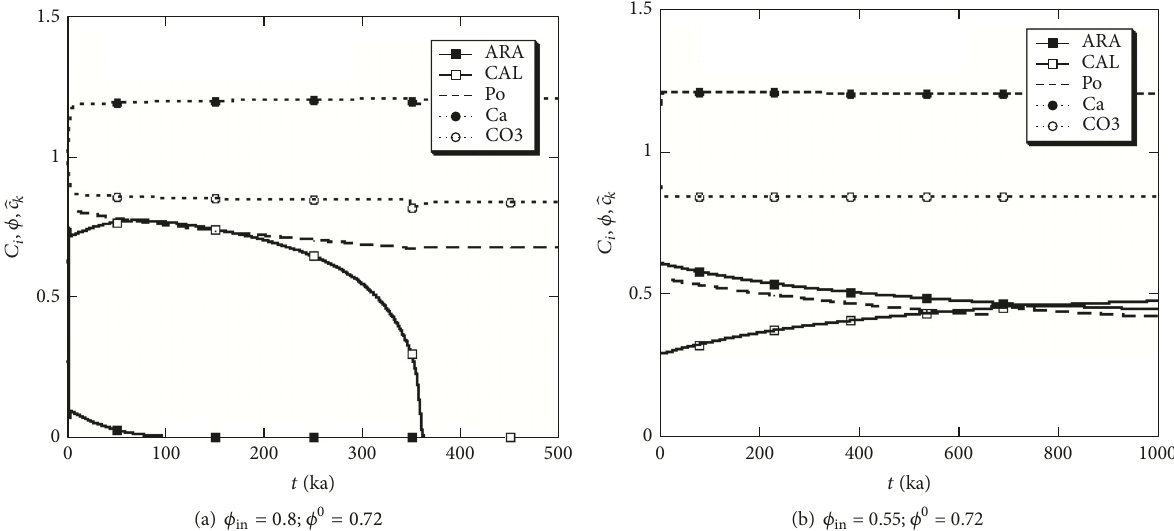
Figure 5: Numerical solutions for scenario A illustrating bistability. All variables are taken at the bottom of the system ( 𝑥 = 𝐿 ) and are plotted as a function of time. (a) 𝜙 in = 0.8 and 𝜙 0 = 0.72. A final steady state 0-0 is obtained. (b) 𝜙 in = 0.55 and 𝜙 0 = 0.72. A final steady state A-C is